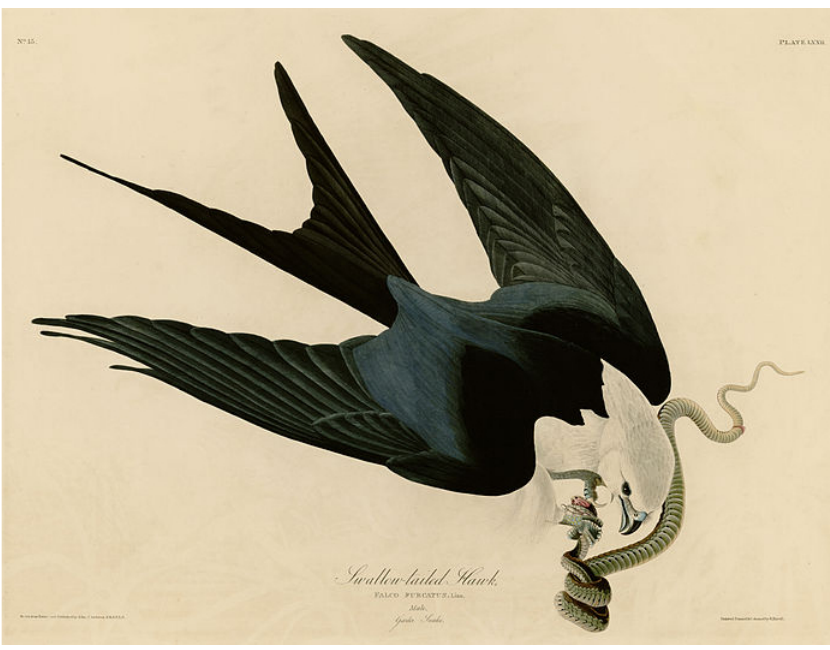
Figure 3. Swallow-tailed Kite by John James Audubon.